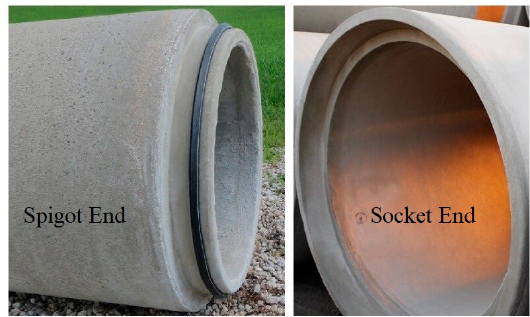
Figure 3. The spigot and socket ends of a concrete pipe in pipe jacking method.